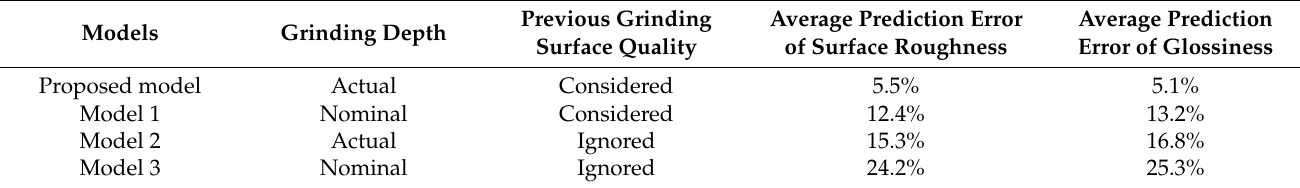
Table 3. The prediction performance of different models for surface quality